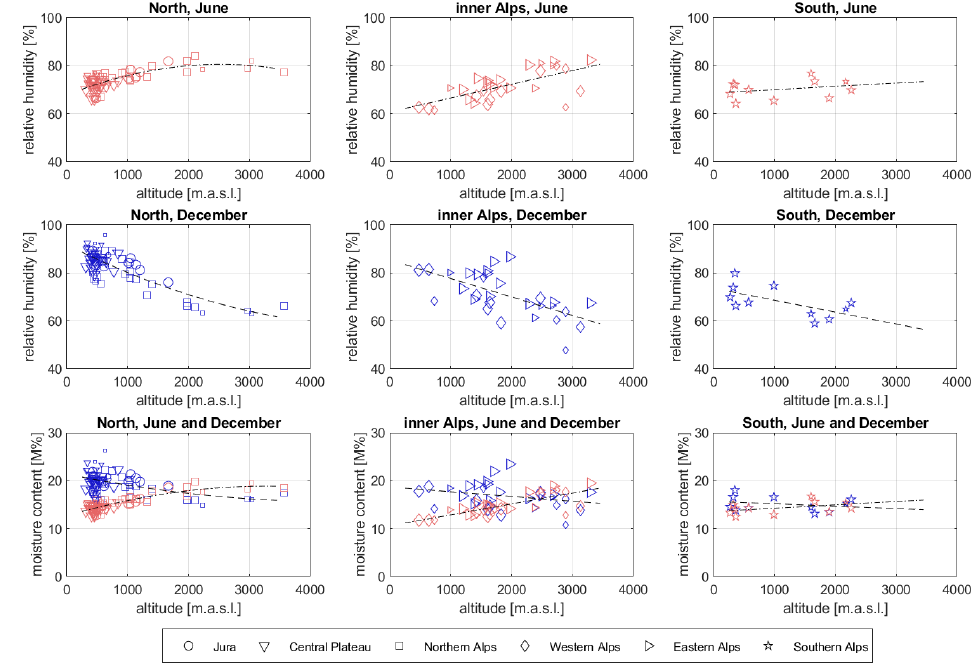
Figure 9. Dependency of relative humidity and moisture content on altitude for each region—north of the Alps, inner Alps, and south of the Alps—along with their trend lines.